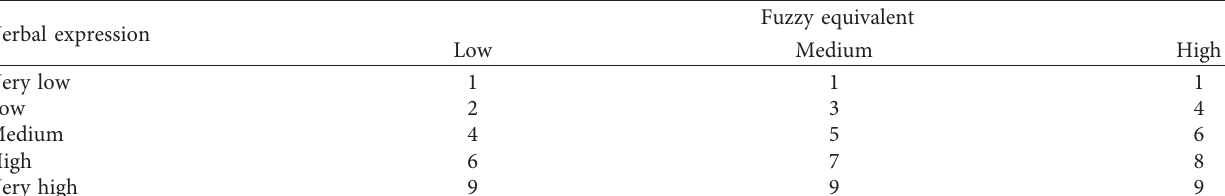
Table 1: Numerical equivalent of fuzzy propositions